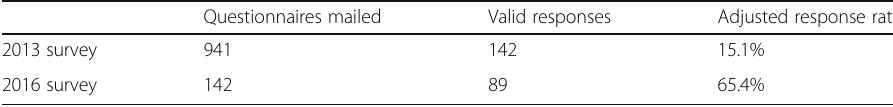
Table 5 Population and sample description for 2013 and 2016